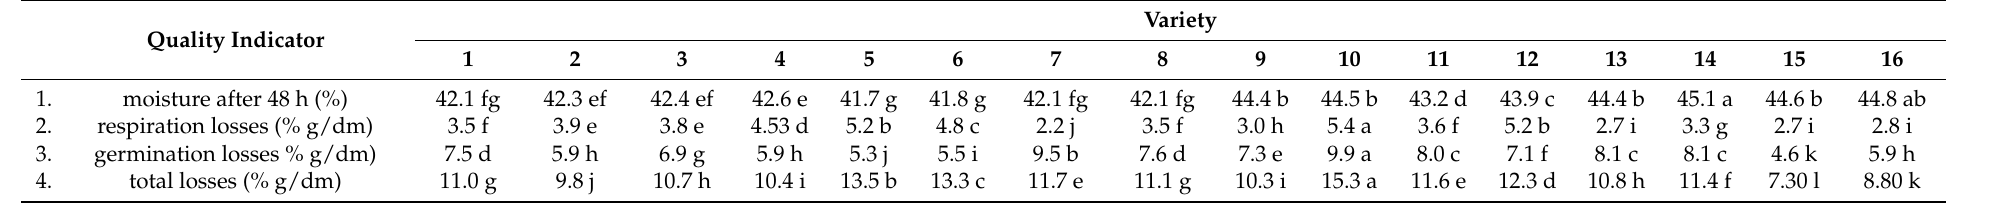
Table 5. Results of micromalting analysis (procedure